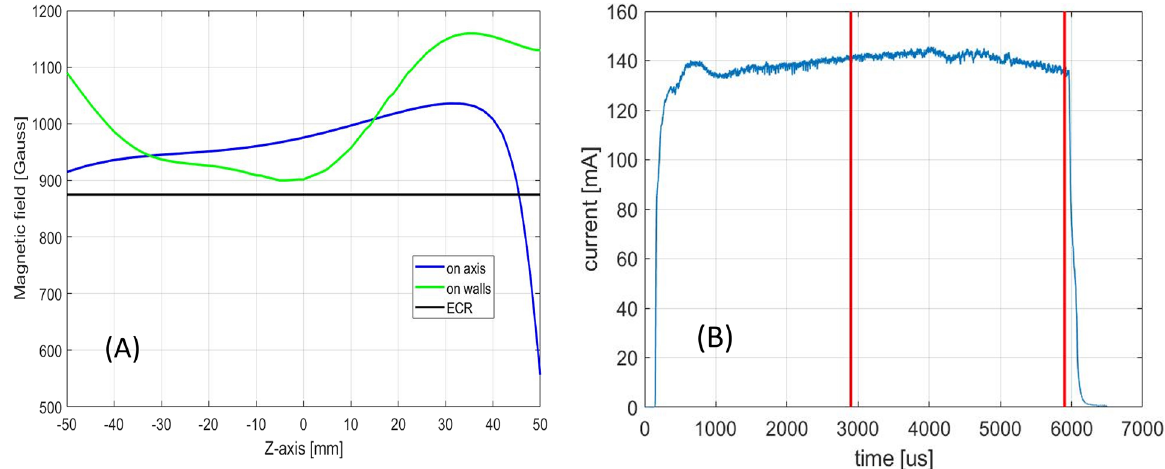
Figure 4. ( A ) Magnetic field configuration at the centre of the high current region; ( B ) Correspondent beam pulse shape produced: only the beam produced within the red lines is transmitted to the